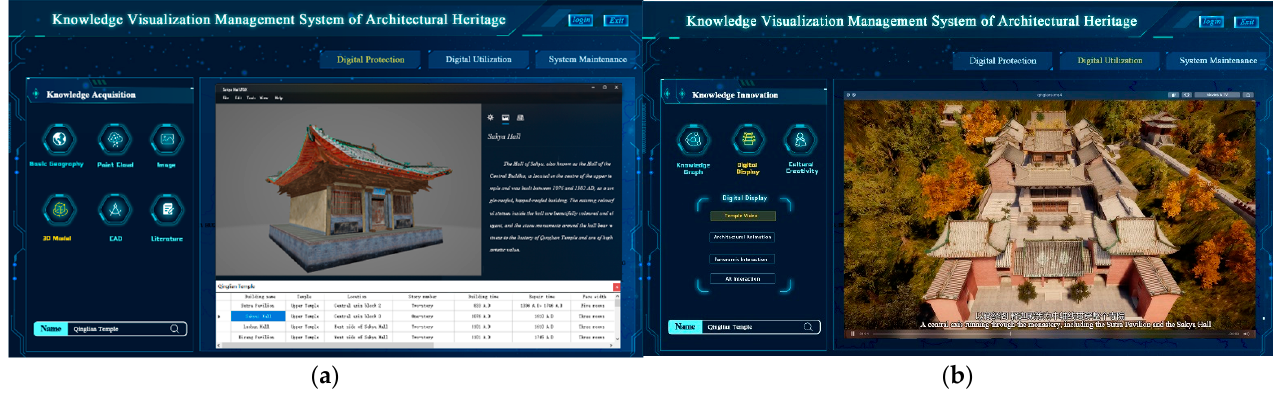
Figure 17. Cultural creativity products: ( a ) digital protection and ( b ) digital utilization.